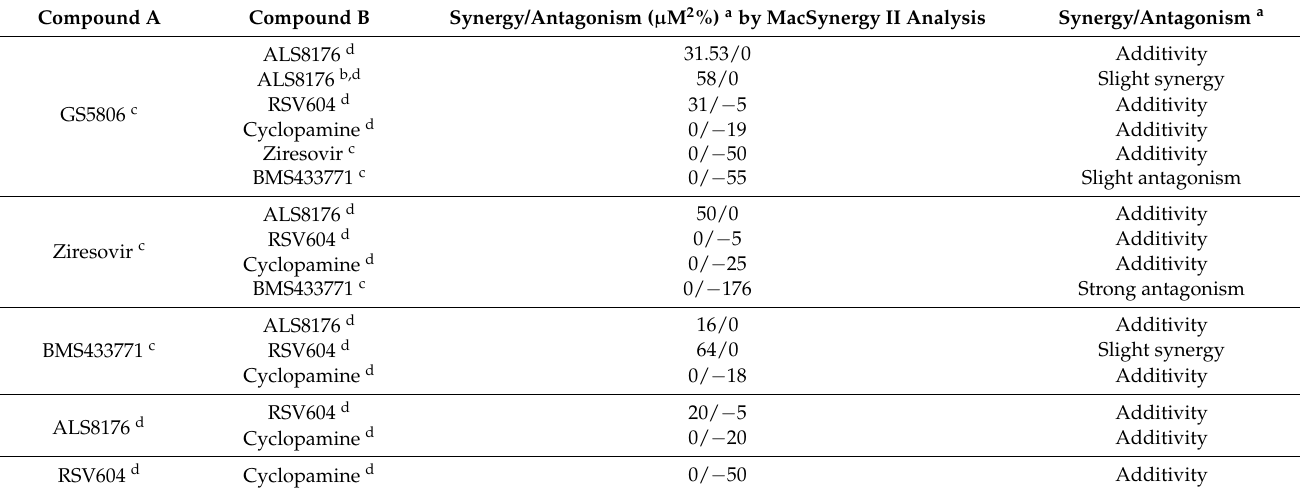
Table 1. Interactions of compound–compound combinations against